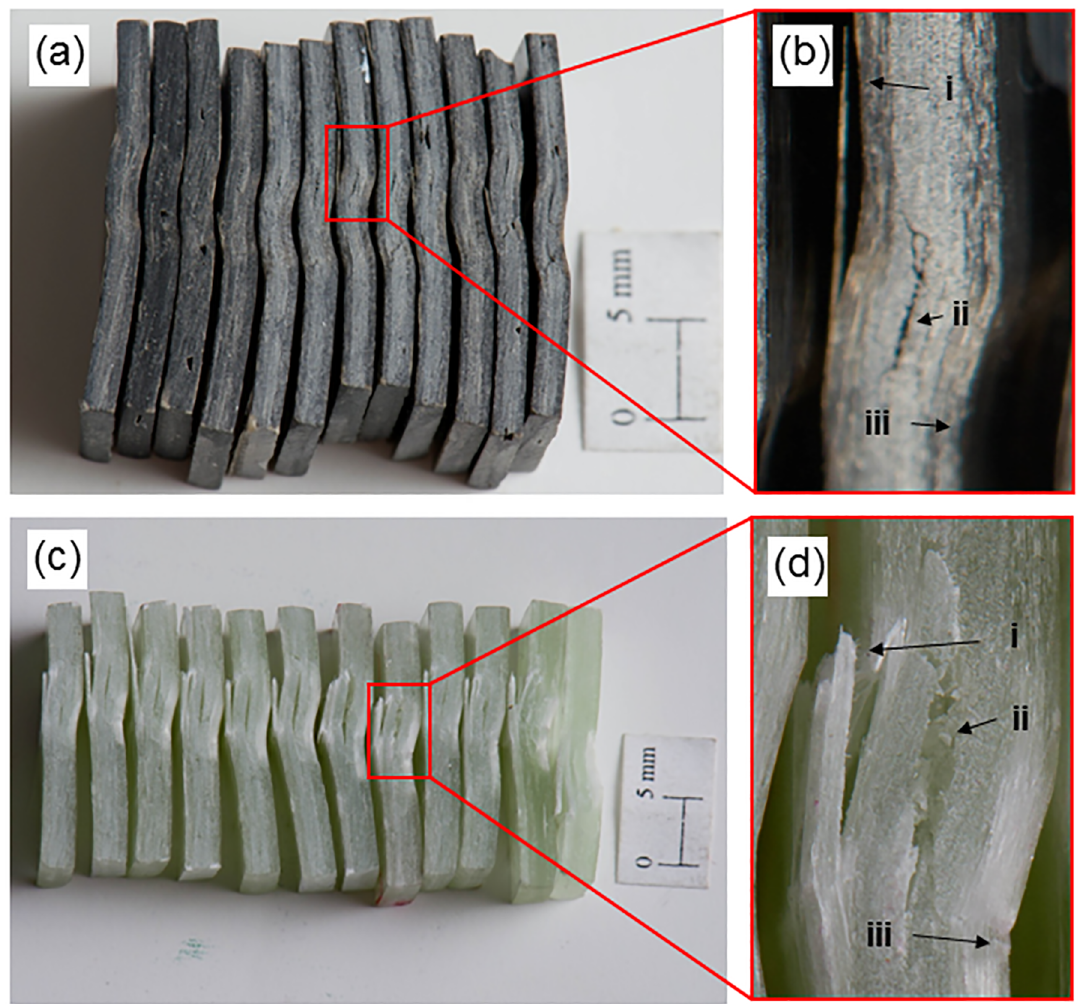
Figure 3. Aspect of (a) BF and (c) GF composite specimens after ILSS test. Identification of failure modes in (b) BF and (d) GF specimens; (i) tension failure, (ii) interlaminar shear, (iii) inelastic deformation.